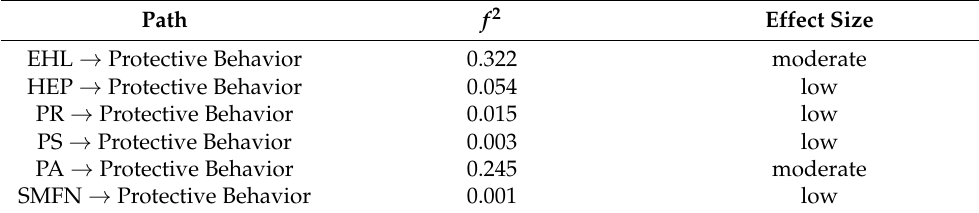
Table 6. Result for Effect Size (ƒ 2